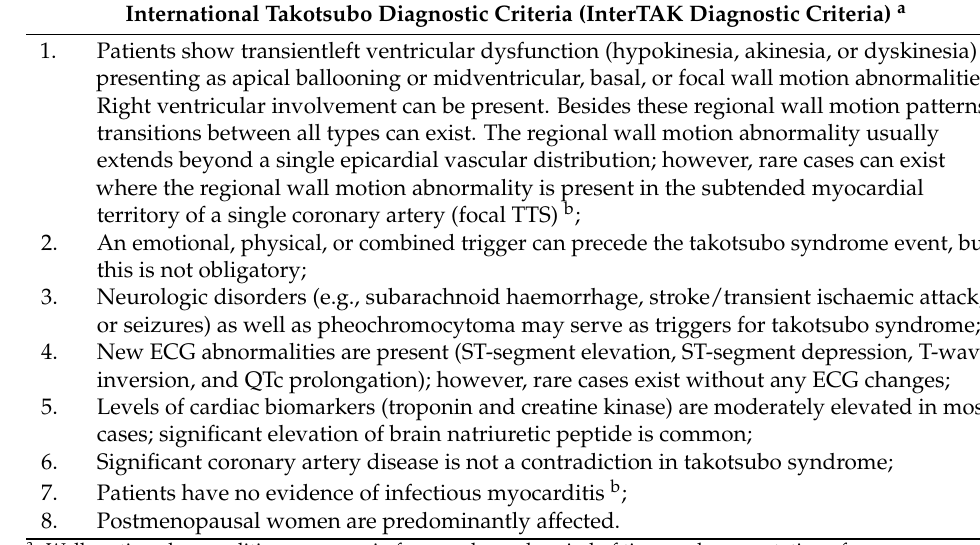
Table 1. International Takotsubo Diagnostic Criteria [2].